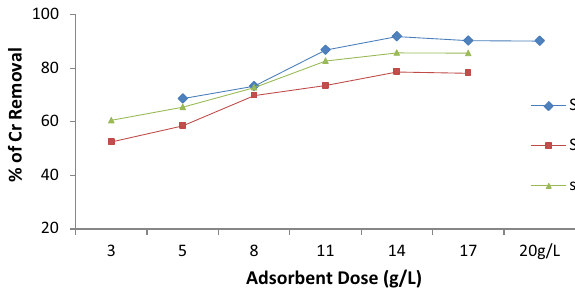
Fig. 11 Effect of adsorbent dose on Cr removal (Nur-E-Alam et